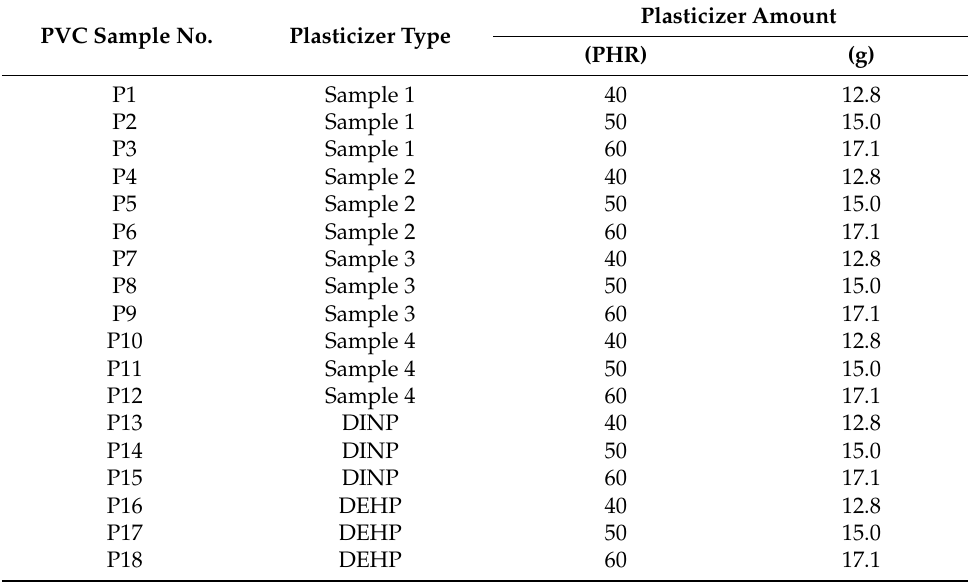
Table 2. Composition of soft PVC